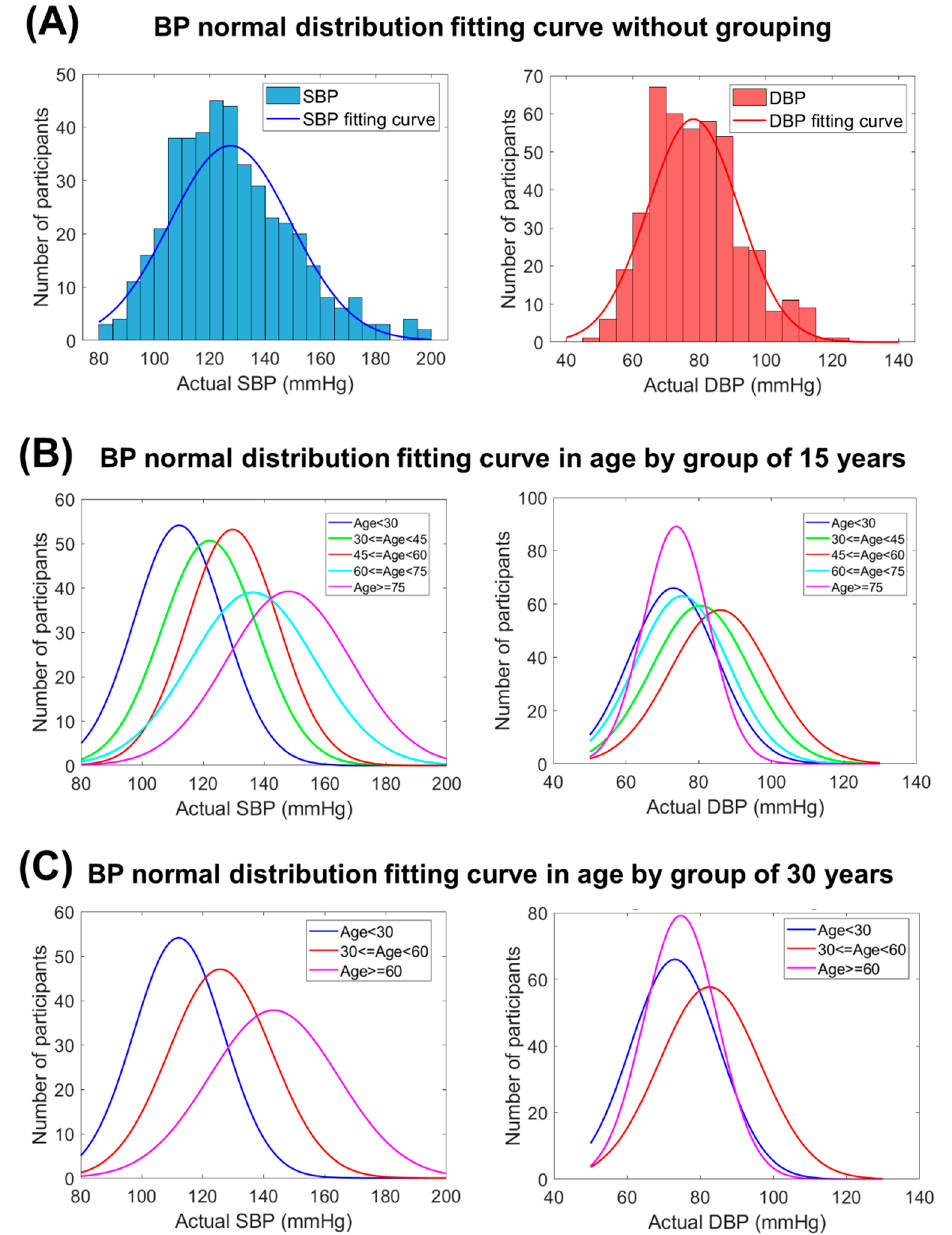
Figure 9. BP distribution with grouping and without grouping. ( A ) BP normal distribution fitting curve without grouping. ( B ) BP normal distribution fitting curve in age by group of 15 years. ( C ) BP normal distribution fitting curve in age by group of 30 years. The distribution fitting curves used to depict distribution normality. After grouping participants, these curves were closer to the null hypothesis of standard normal distribution test which was more suitable for exponential GPR training model. In Figure 9B,C , the fitting curves of actual SBP and DBP shifted to higher-value along with older age groups. Nevertheless, the fitting curves of actual DBP shifted back to lower-value when the age was older than 60 years (light blue and purple line).